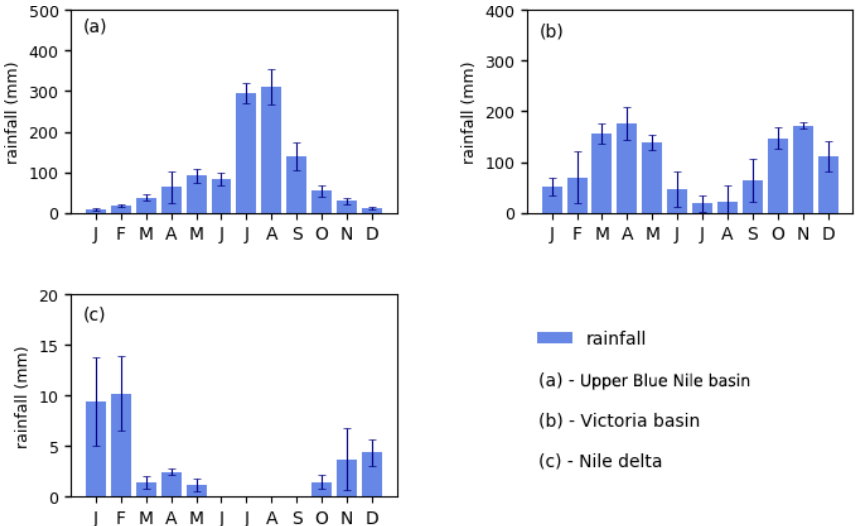
Figure 5. Long-term monthly mean and standard deviation (lines) rainfall pattern for selected HRUs in selected basins within the